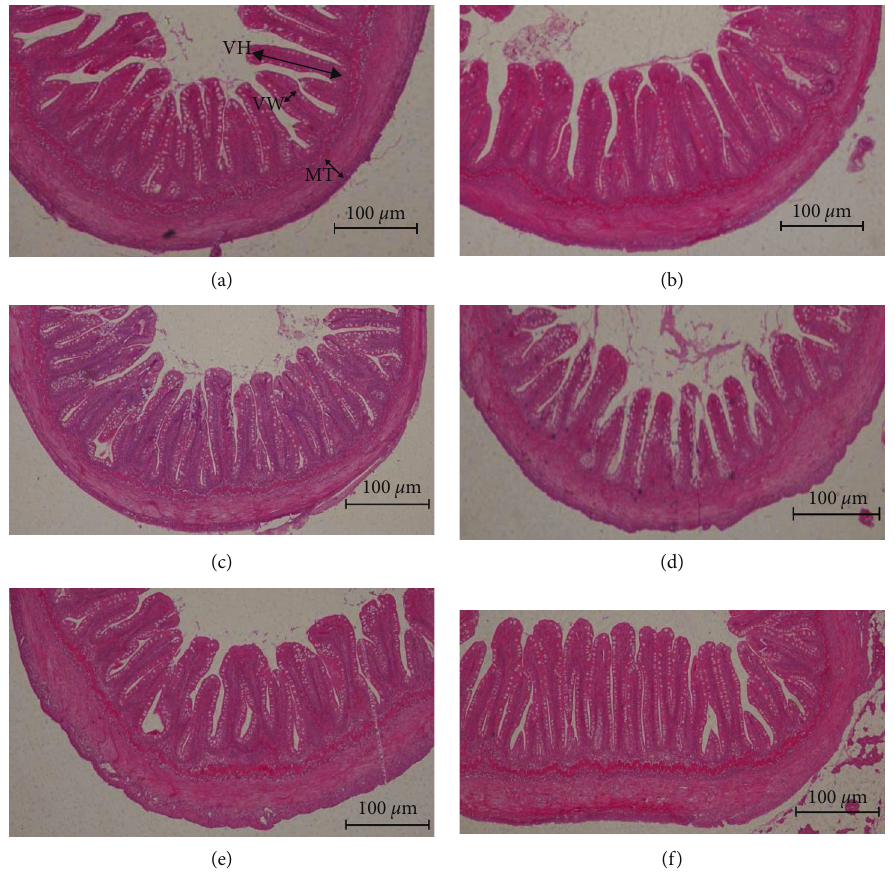
Figure 1: E ff ect of dietary inclusion of sodium butyrate on intestinal structure of rainbow trout (MT: muscular thickness; VH: villus height; VW: villus width). (a) High fi shmeal group; (b) high fi shmeal +1.0 g/kg NaB; (c) high fi shmeal +2.0 g/kg NaB; (d) low fi shmeal group; (e) low fi shmeal +1.0 g/kg NaB; and (f) low fi shmeal +2.0 g/kg